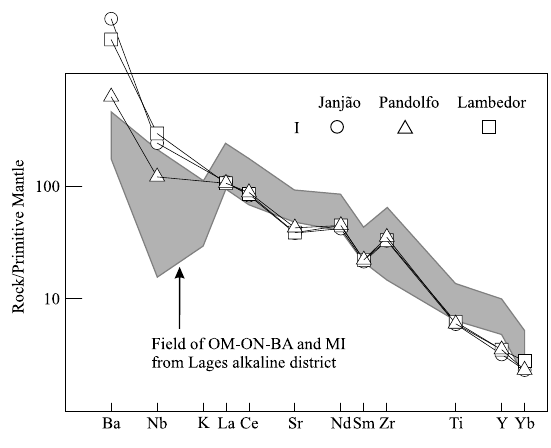
Fig. 13 – Primitive mantle normalized (Sun and McDonough 1989) REE and trace element patterns of the calculated hypothetical liquids equilibrated with the clinopyroxene megacrysts from the Janjão, Pan- dolfoandLambedordiatremescomparedwithLagessilicaterock-types (OM, olivine melililite; ON, olivine nephelinite; BA, basanite; MI, minette; cf. Traversa et al. 1994, Gibson et al. 1995). Liquids were calculated from megacrysts composition using the clinopyroxene-melt partition coefficients for silicate systems of Hart and Dunn